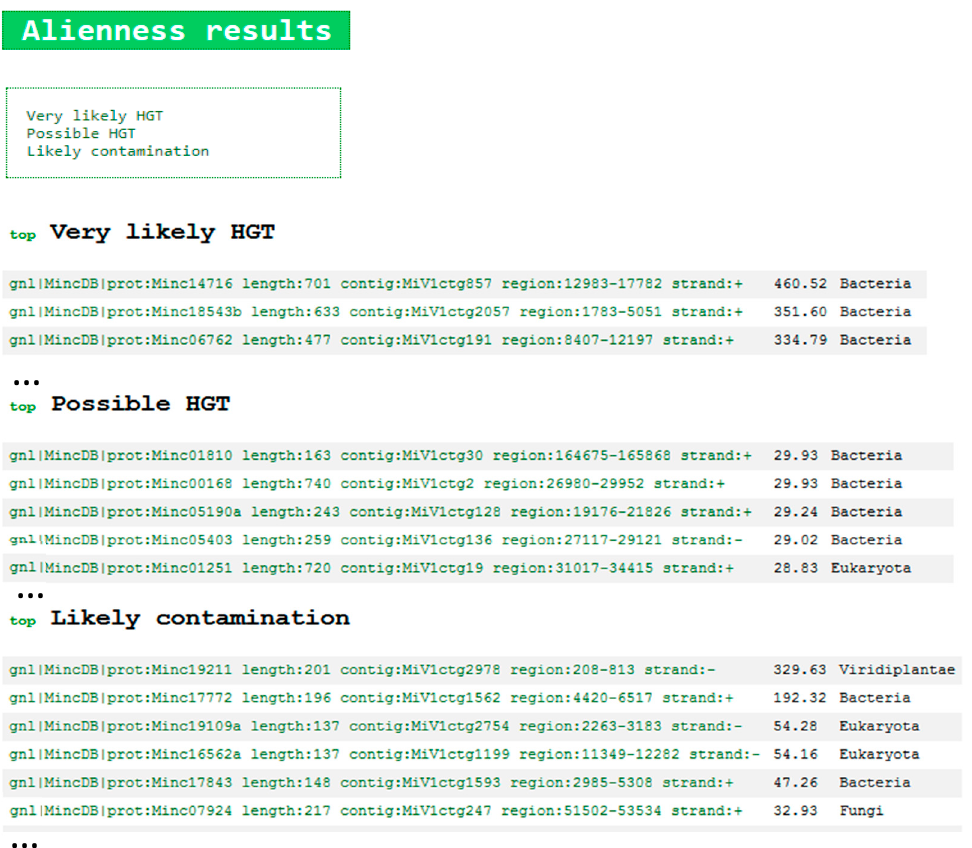
Figure 3. The .html index file opened in a web browser to explore the BLAST results by category (Very likely HGT, Possible HGT and Likely contamination).